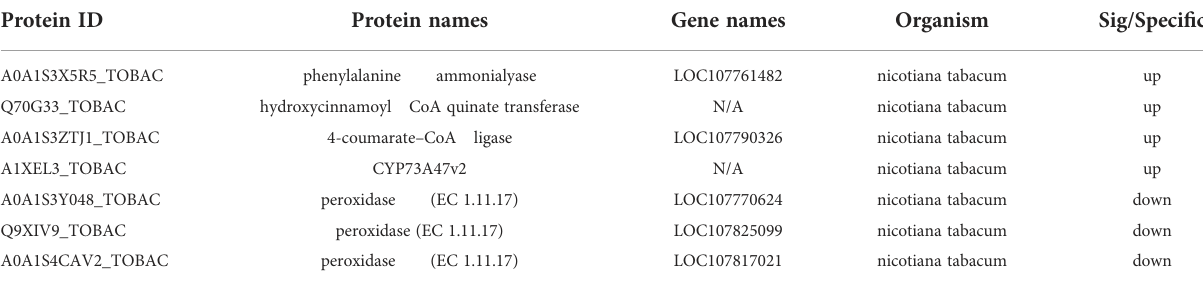
TABLE 4 DEPs involved in the phenylpropanoid biosynthesis